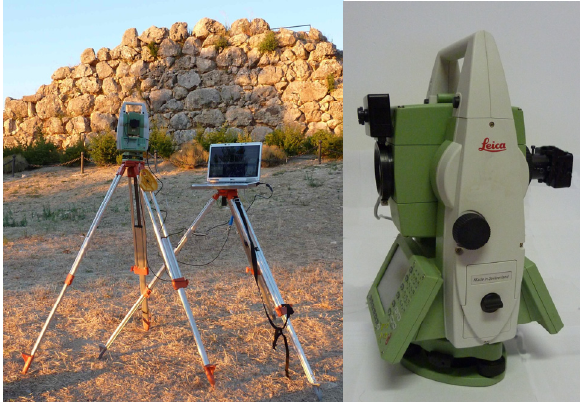
Figure 1. Sensor system. Right: total station and laptop. Left: total station and coupled cameras.